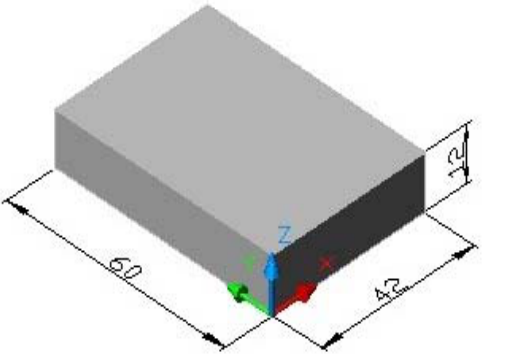
Fig. 1. The workpiece with its dimensions.